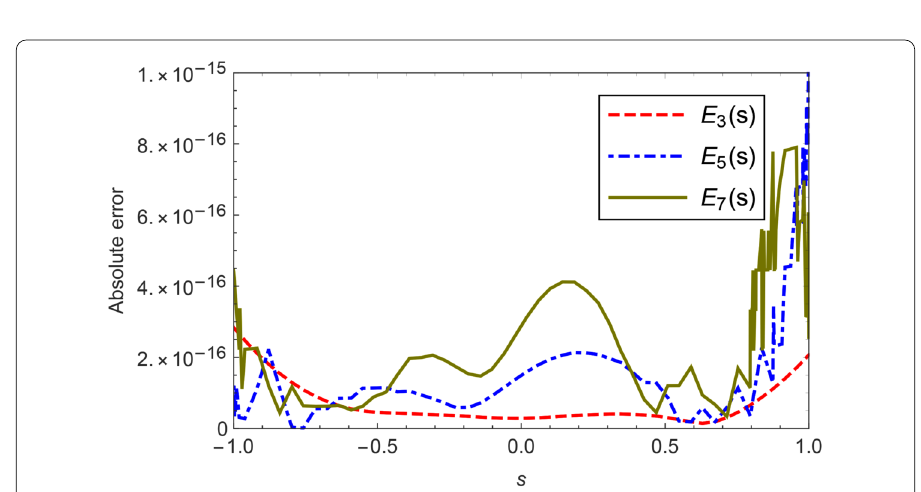
Figure 8 Absolute errors | E n ( s ) | for Example 4 with m =